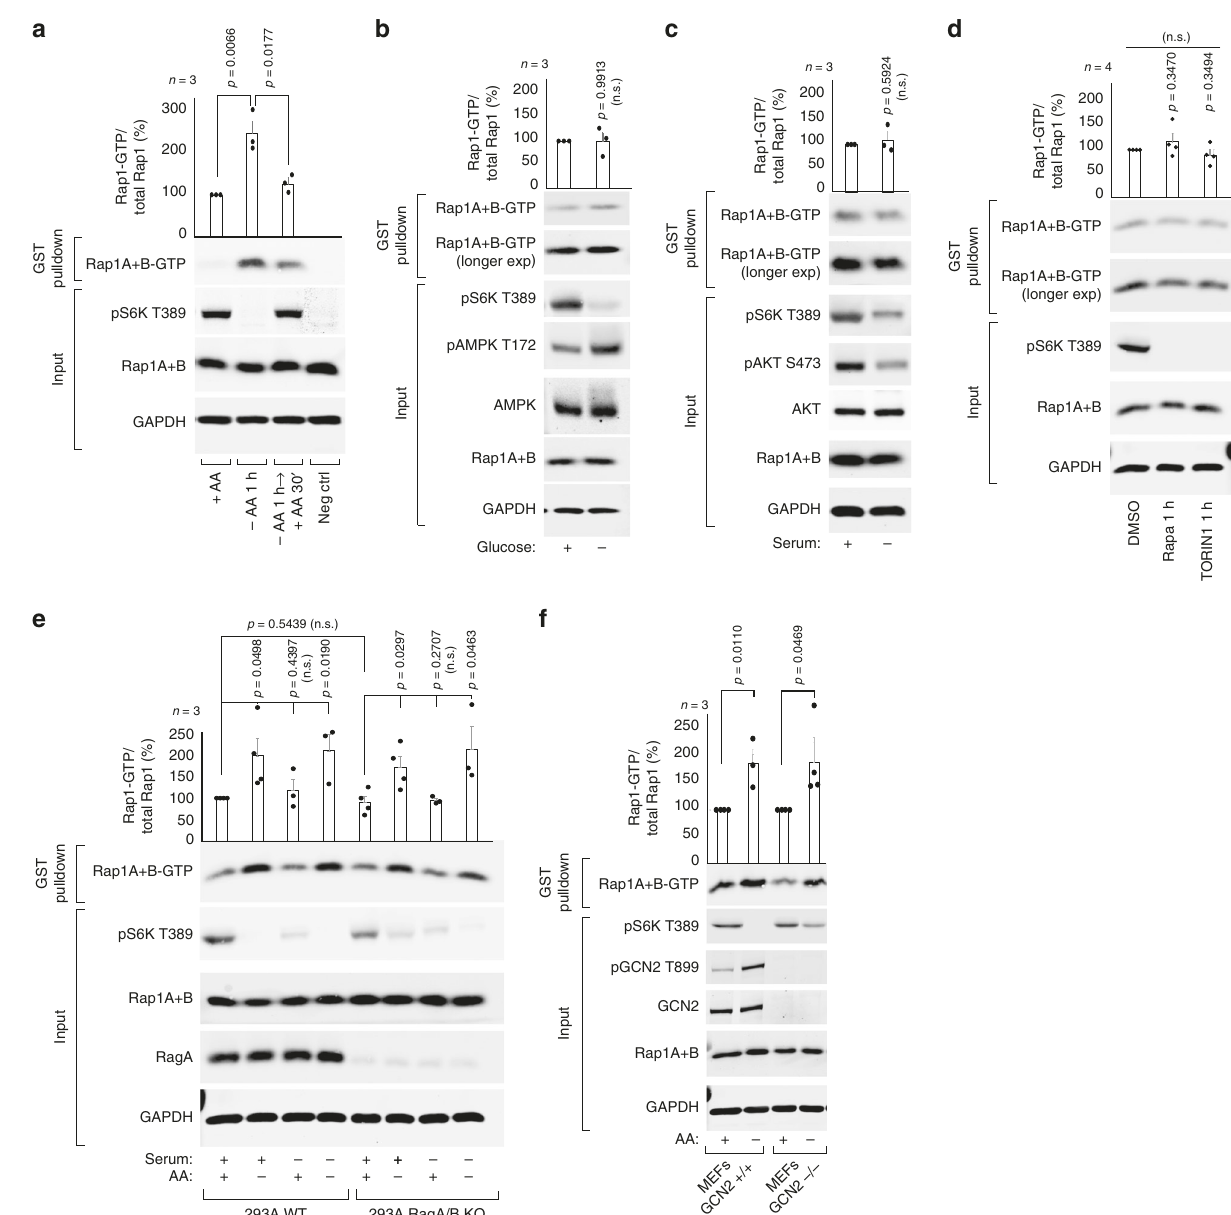
Fig. 2 Amino acid deprivation induces Rap1 activity. In a through ( f ), endogenous Rap1 activity (Rap1A + B-GTP) was assessed through immunoprecipitation of GTP-bound Rap1 and immunoblotting against the indicated proteins. Cells had been subjected to 1 h depletion of all amino acids ( − AA) ( a , e , f ), glucose ( b ) or serum ( c , e ), and re-stimulated with amino acids for 30 min ( a ), or treated for 1 h with 20 nM Rapamycin (Rapa), 50 nM Torin1 or DMSO control ( d ). Lysates were prepared from serum deprived HEK293T cells ( a ), HEK293A cells ( b – d ), RagA/B knockout HEK293A cells ( e ) or MEF cells de fi cient in GCN2 ( f ). Graphs represent relative immunoblot band intensity from n experiments: a , b , c , e , f n = 3, d n = 4. In a , d , e , f Rap1-GTP and total Rap1 were processed on separate blots due to technical reasons. Statistical data are presented as mean values ± s.e.m. n.s. = not signi fi cant ( P > 0.05); Student ’ s t -test; two-sided, unpaired. See Source Data File for statistics source data. Uncropped images of blots are shown in Supplementary Fig.